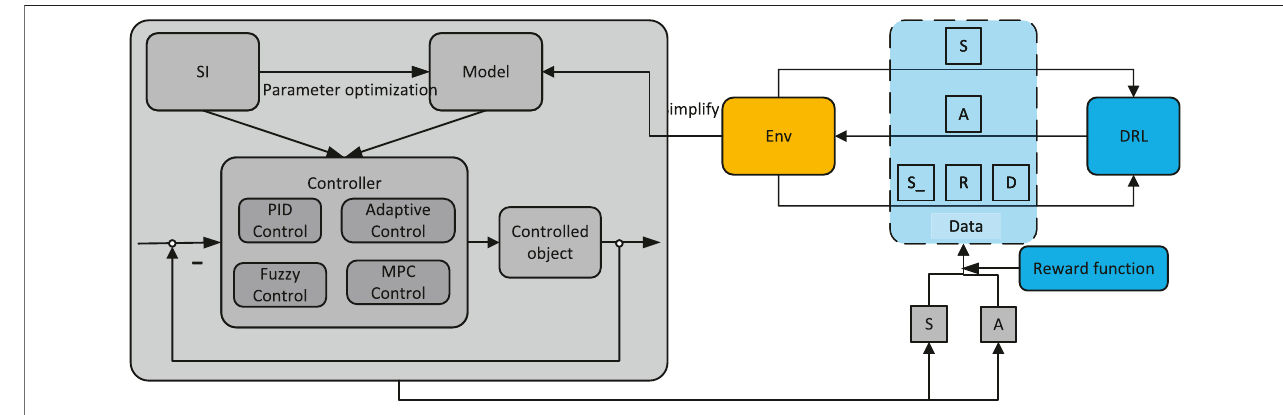
FIGURE 1 | Framework for algorithms driven by data and